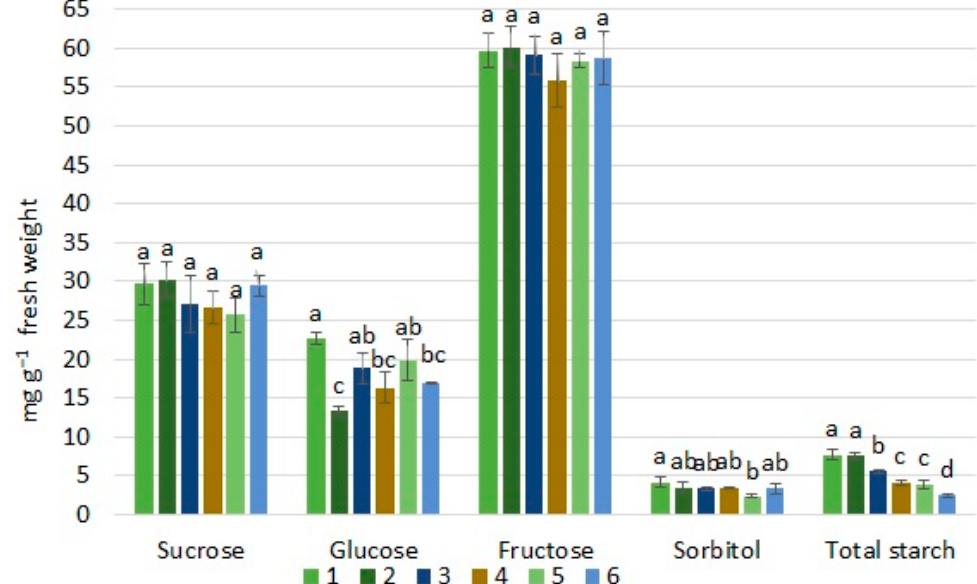
Figure 1. Influence of agrotechnological tools on carbohydrate content in cv. Rubin apples on harvest time (commercial ripening) in average of three years. 1. Each year hand pruning forming slender spindle (control); 2. Mechanical pruning (each year); 3. Trunk incision using chain saw + mechanical pruning (each year); 4. Mechanical pruning (each year) + spraying with calcium-prohexadione; 5. Mechanical pruning + hand pruning + summer pruning; 6. Mechanical pruning one side, changing sides annually. Averages followed by different letter within the same compound indicate significant differences according to the Duncan’s least significant difference test ( p < 0.05). Error bars show standard deviation.